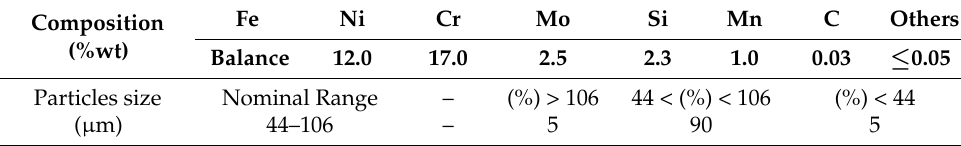
Table 1. Composition and particle size distribution of the MetcoClad™ 316L-SI powder.